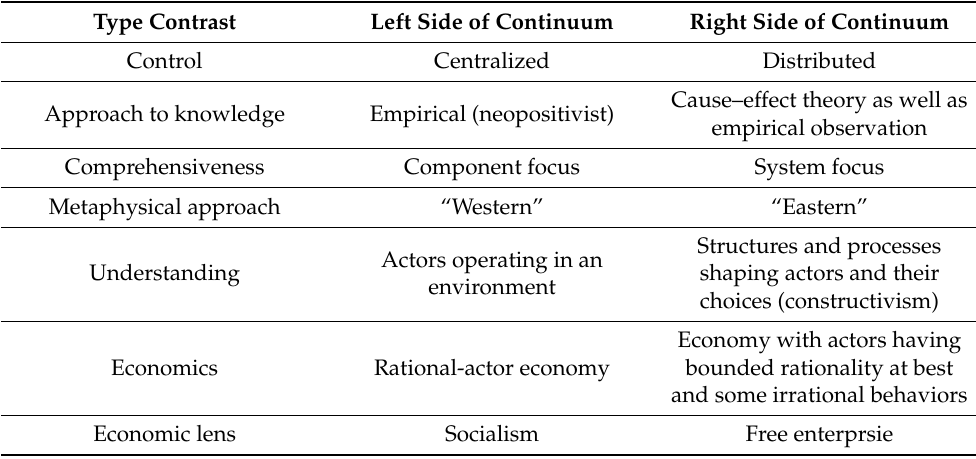
Table 1. Illustrative alternative perspectives for which modeling might be desired. Type Contrast Left Side of Continuum Right Side of